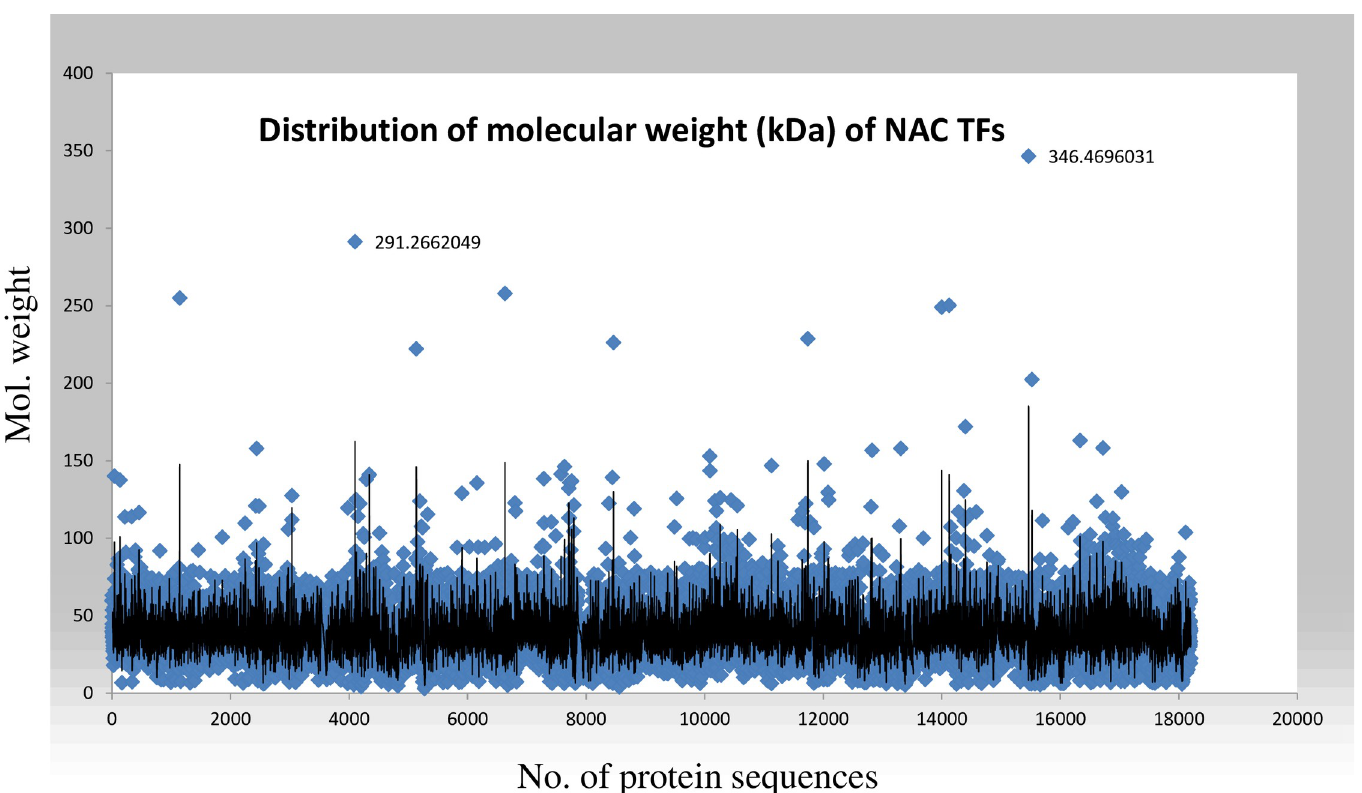
Fig 1. The distribution of the molecular weight of NAC TFs. The molecular weight of NAC TFs ranged from 2.94 kDa ( Fragaria x ananassa , FANhyb_icon00034378_a.1.g00001.1) to 346.46 kDa ( Trifolium pratense , Tp57577_TGAC_v2_mRNA14116). The average molecular weight of NAC TFs was 38.72 kDa. In total, 17158 NAC TFs were utilized in the analysis of molecular weight. The analysis was conducted using a protein isoelectric point calculator (http://isoelectric.org/).